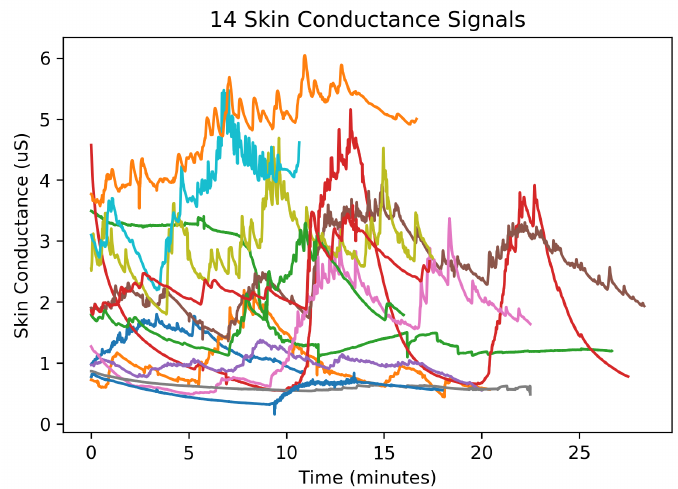
Figure 5. The collection of electrodermal activity signals used to evaluate the compression